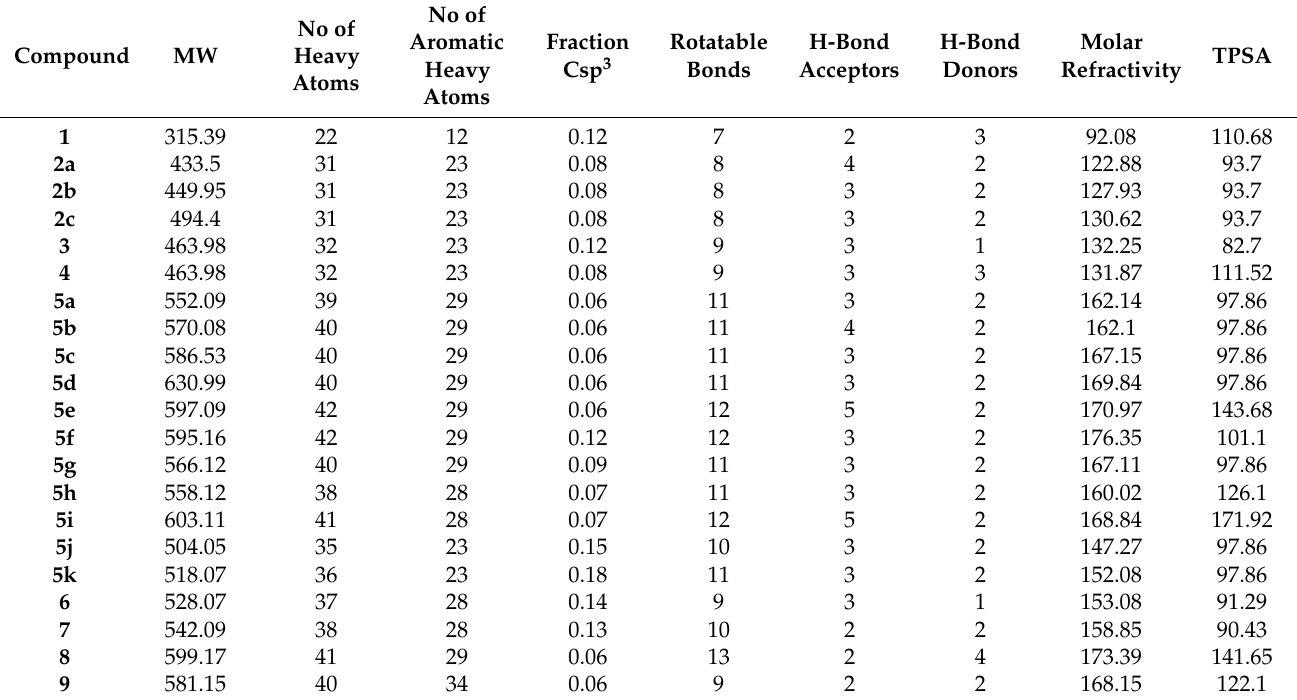
Table 1. The in silico physicochemical properties of thiazole derivatives bearing β -amino acid and aromatic